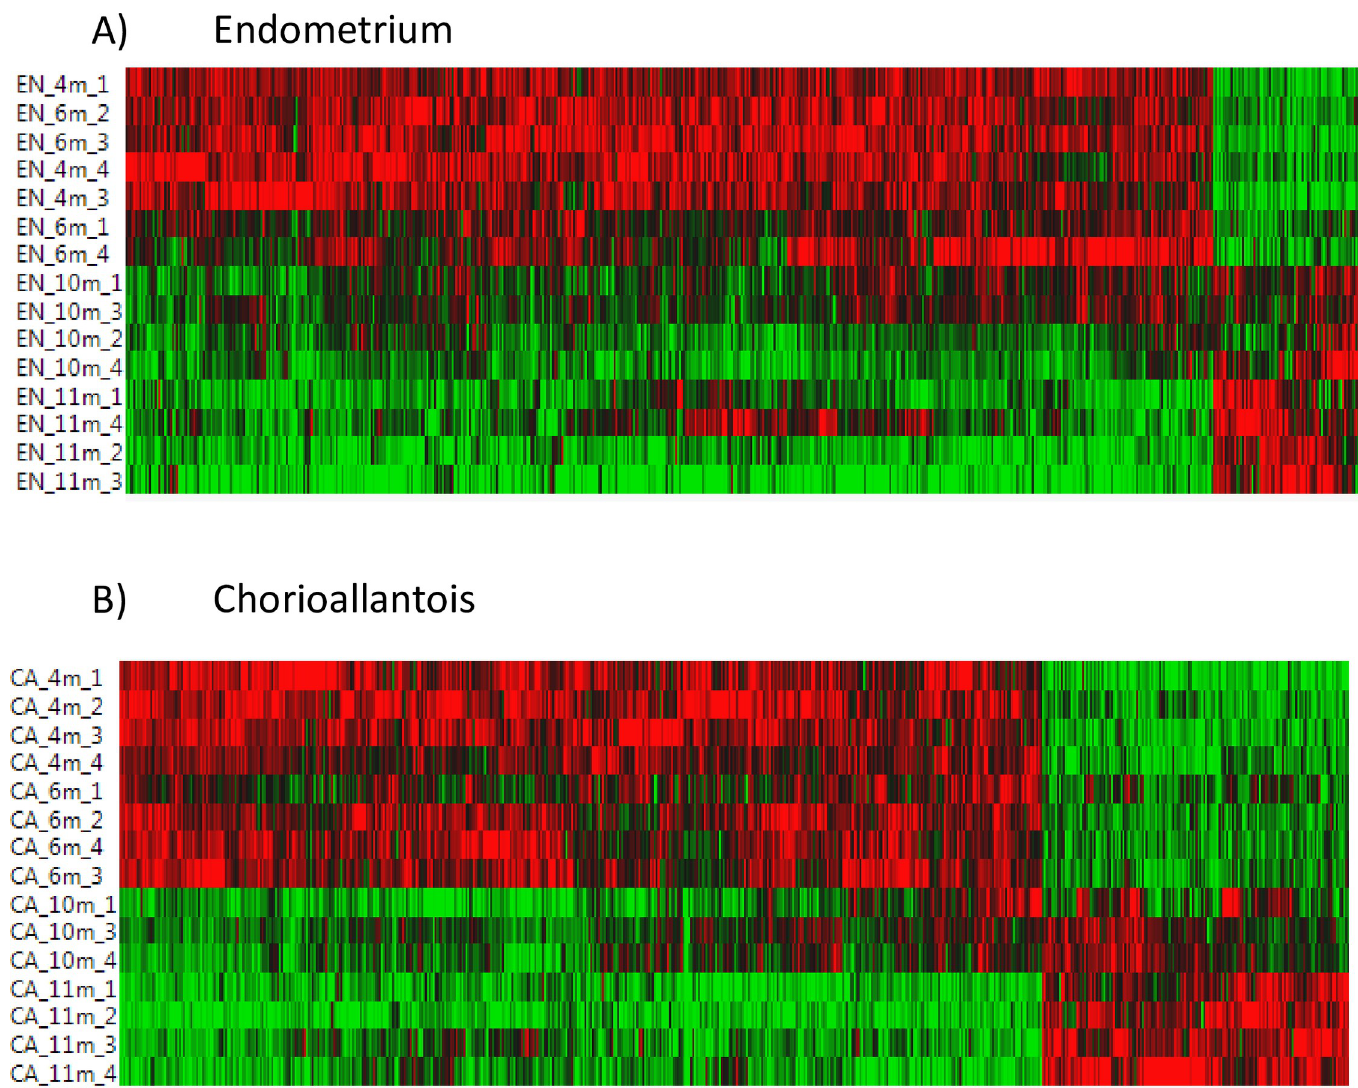
Fig 1. Heat map of endometrium and chorioallantois. Clustered heat map showing relative gene expression / sample for all differentially expressed genes (FDR P-Value < 0.05) at each gestational age. Includes A) endometrium, excluding diestrus and B) chorioallantois at 4, 6, 10 and 11 m gestation. (r = 0.25). Analysis of correlation between CA and EN by month of gestation (Table 1) revealed